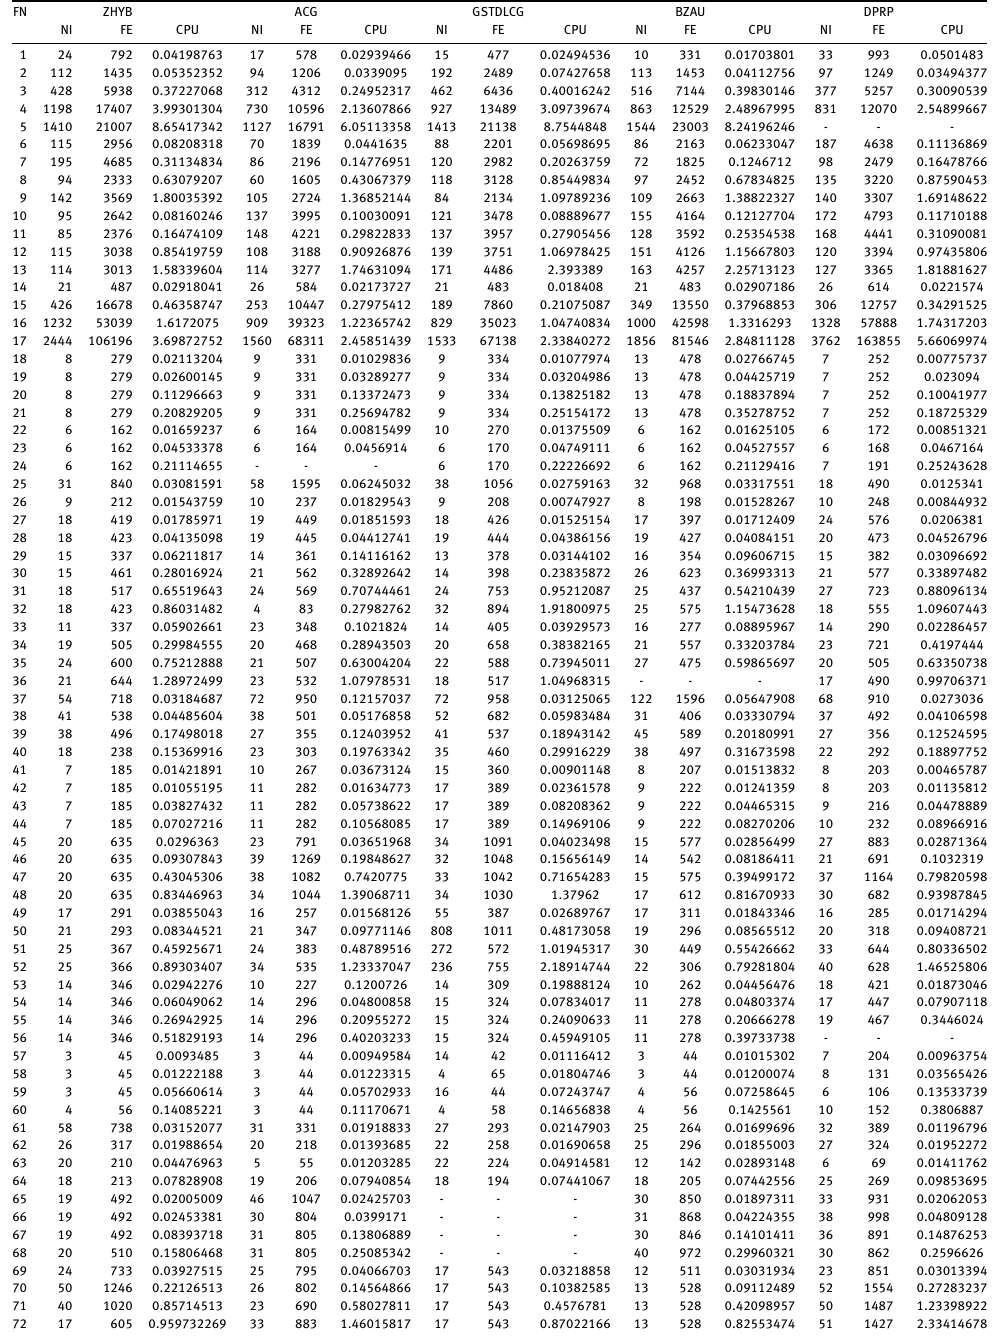
Table 2: Table of number of iterations, function evaluations and CPU